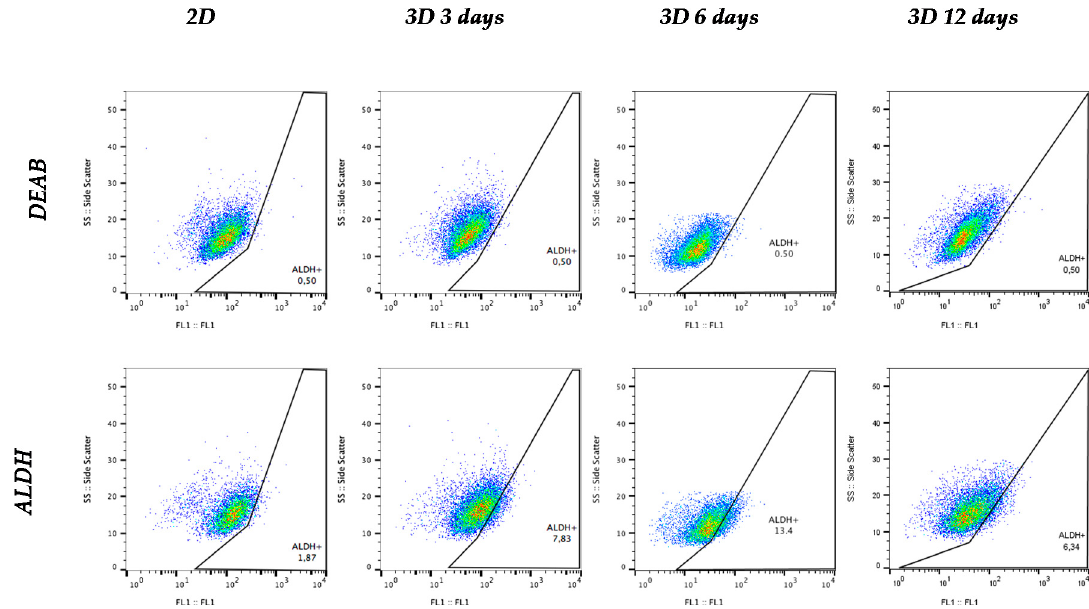
Figure 6. ALDEFLUOR assay plots of MDA–MB–231 cells cultured on monolayer (2D) and on 15% PCL scaffolds (3D). Aldehyde dehydrogenase (ALDH) inhibitor (diethylaminobenzaldehyde; DEAB) was processed to determine background fluorescence limit, gating 0.5% ALDH-positive cells for all samples.